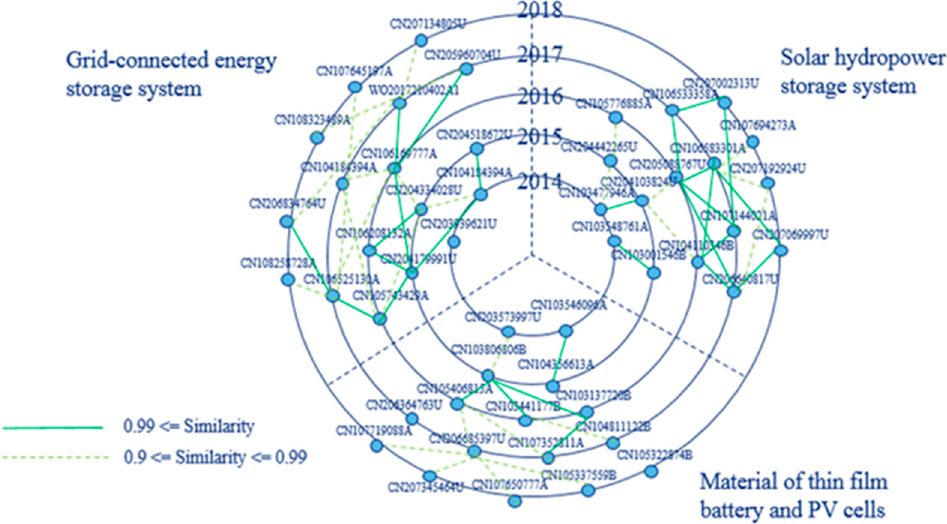
Figure 12. Evolution graph for three clusters of solar patents.